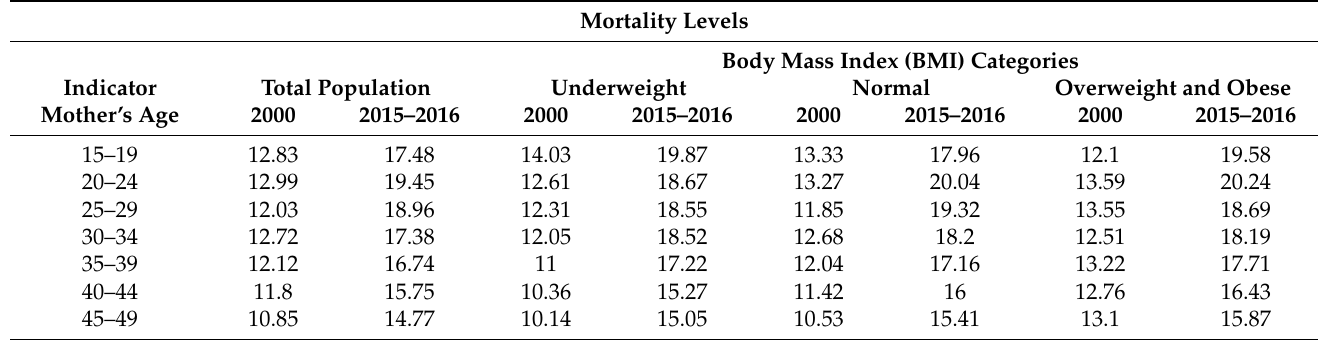
Table 3. Estimates of child mortality via parity and child survival among females. Mortality Levels Body Mass Index (BMI)